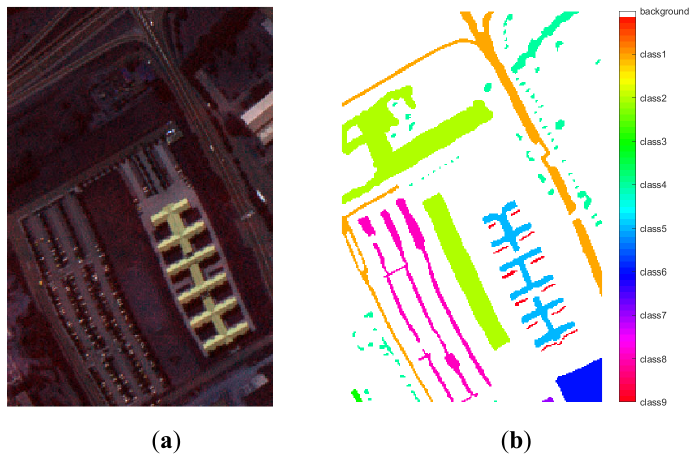
Figure 3. The Pavia University dataset. ( a ) RGB image (band 1,20,40). ( b ) Reference land-cover map (nine classes). Table 2. Land cover classes with the number of samples for the Pavia University dataset.